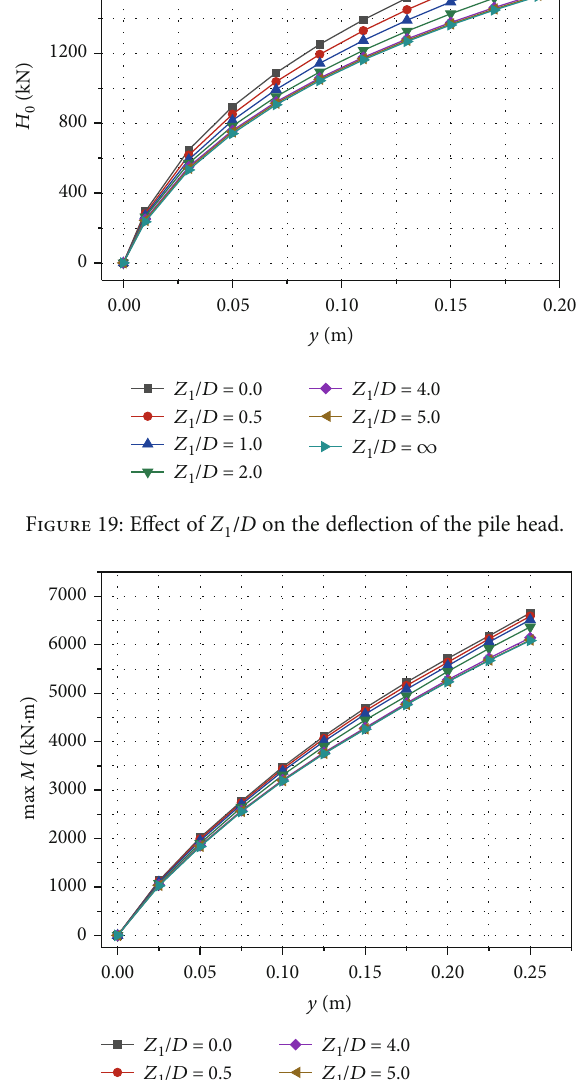
Figure 20: E ff ect of Z